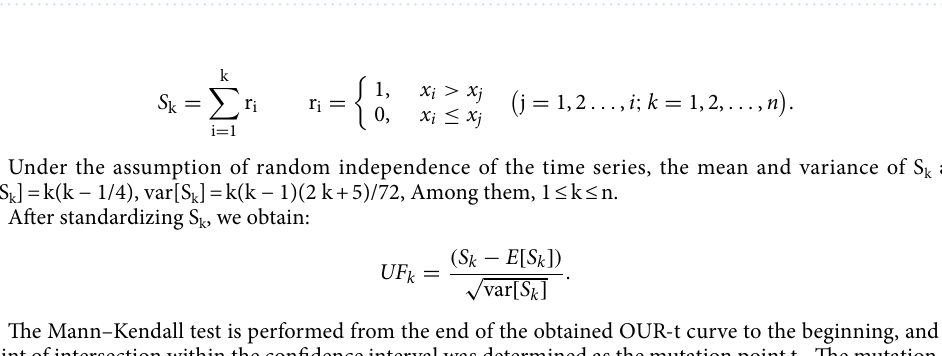
Table 3. Sequential column data of